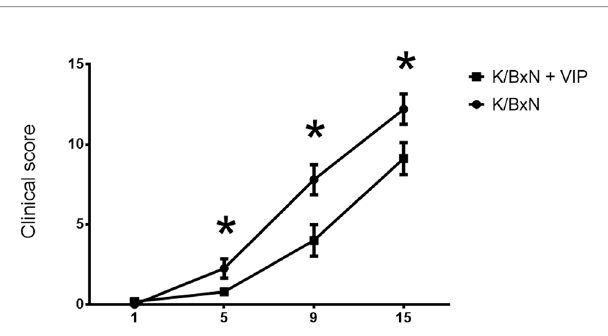
FIGURE 1 | Time course of clinical score values (mean ± SEM) in untreated and VIP treated K/BxN mice. X axis represents days of treatment (beginning on day 21 of age). *p <